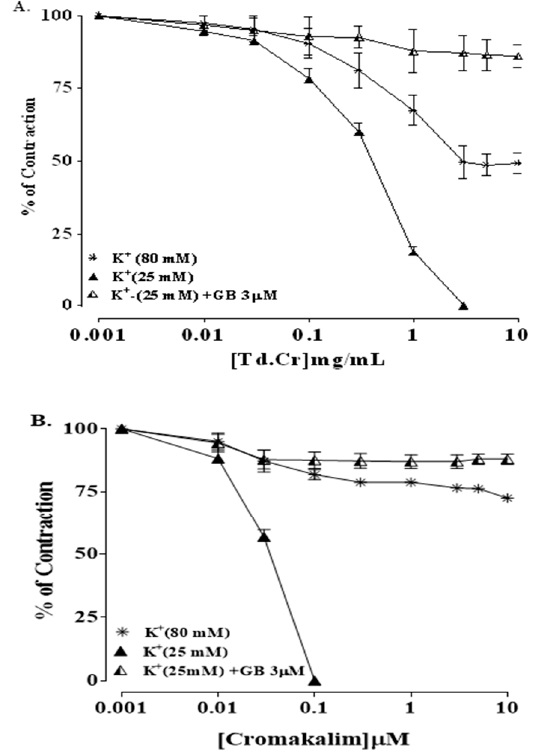
Figure 6. Concentration-response graphical presentation of ( A ) TdCr compared with ( B ) cromakalim against K+ (80 mmol/L) in the absence or presence of glibenclamide (GB; 3 μ mol) in isolated jejunal preparation. Values shown as mean ± SEM, n = 5.